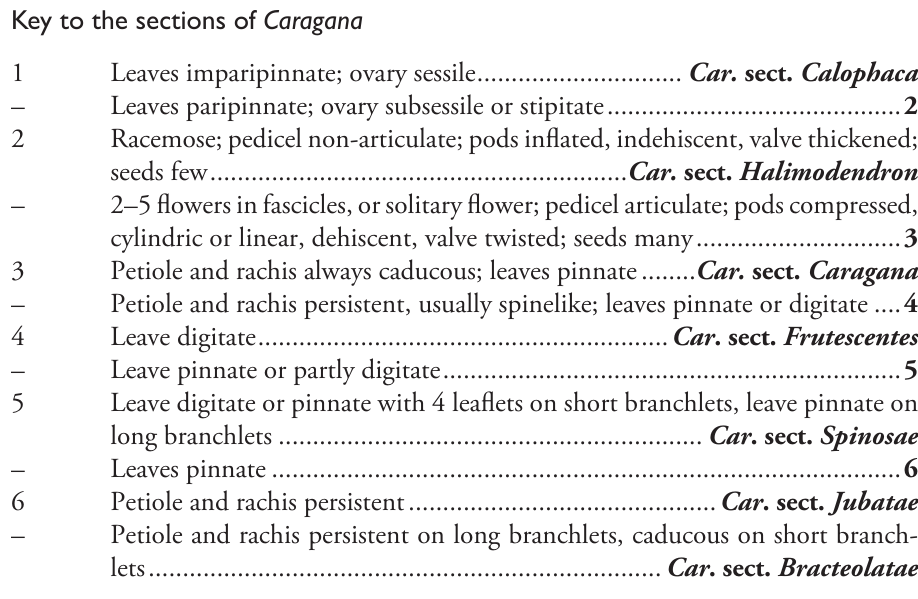
Chesneya sect. Chesneya Fig. 3B Chesneya sect. Macrocarpon Boriss., Fl. U.S.S.R. 11: 280. 1945. syn. nov. Type: Chesneya rytidosperma Jaub. et Spach, Ill. Pl. Orient. 1(5): 93.